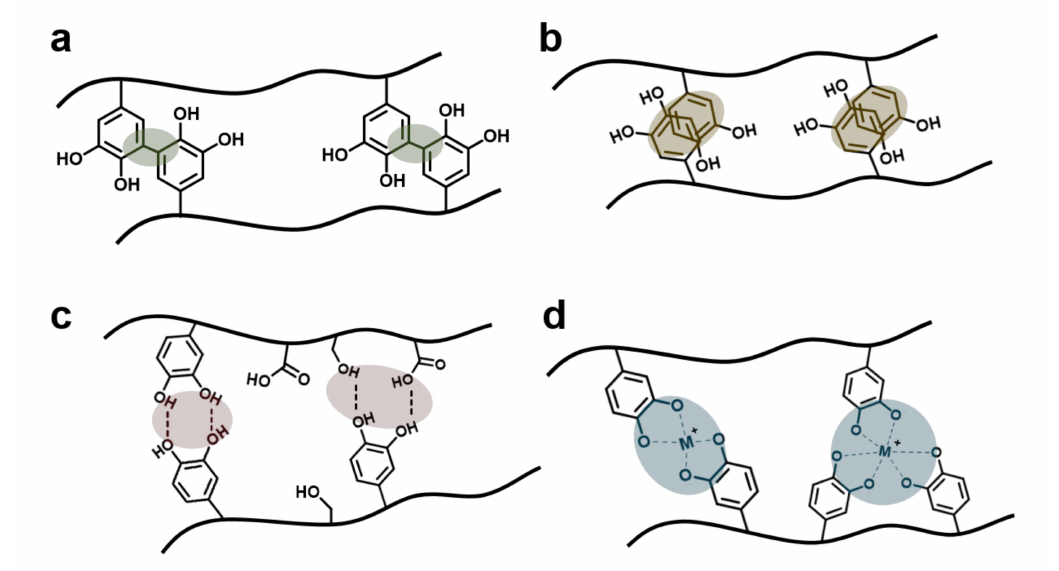
Figure 3. Schematic illustration of catechol-involving reactions of HA–catechol: ( a ) covalent bonds, ( b ) π – π stacking, ( c ) hydrogen bonds, and ( d ) metal